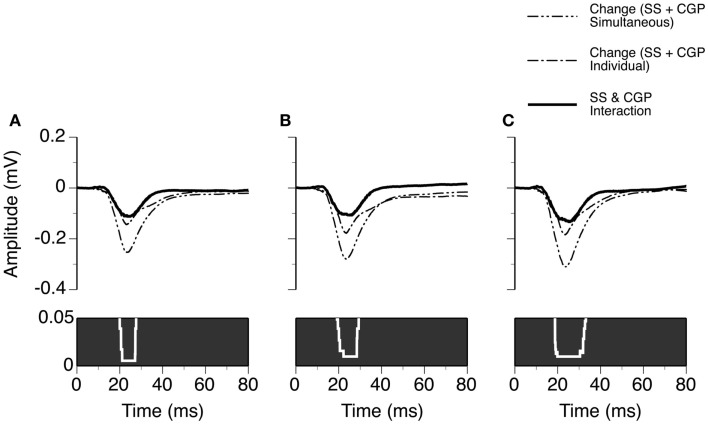
Group results (n = 8) showing the time window over which a synergistic interaction exists between SS and CGP35348 in enhancing the amplitude of an LFP recorded at the BF of a recording site. (A–C) are results obtained at 10, 20, and 30 dB above the MT of a recording site, respectively. In (A–C), a white line with a black background in the bottom panel is a p-value by time function showing statistical significance of the difference between the total changes caused by individual and simultaneous applications of SS and CGP35348.